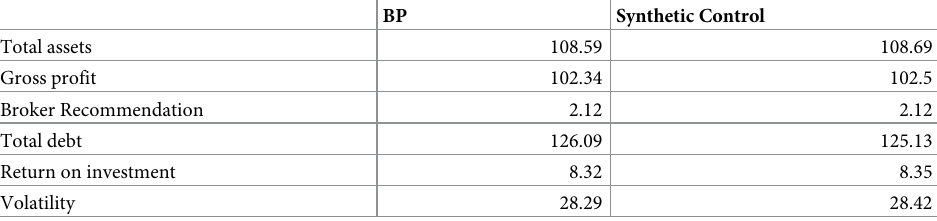
Table 2. Predictor balance for financial